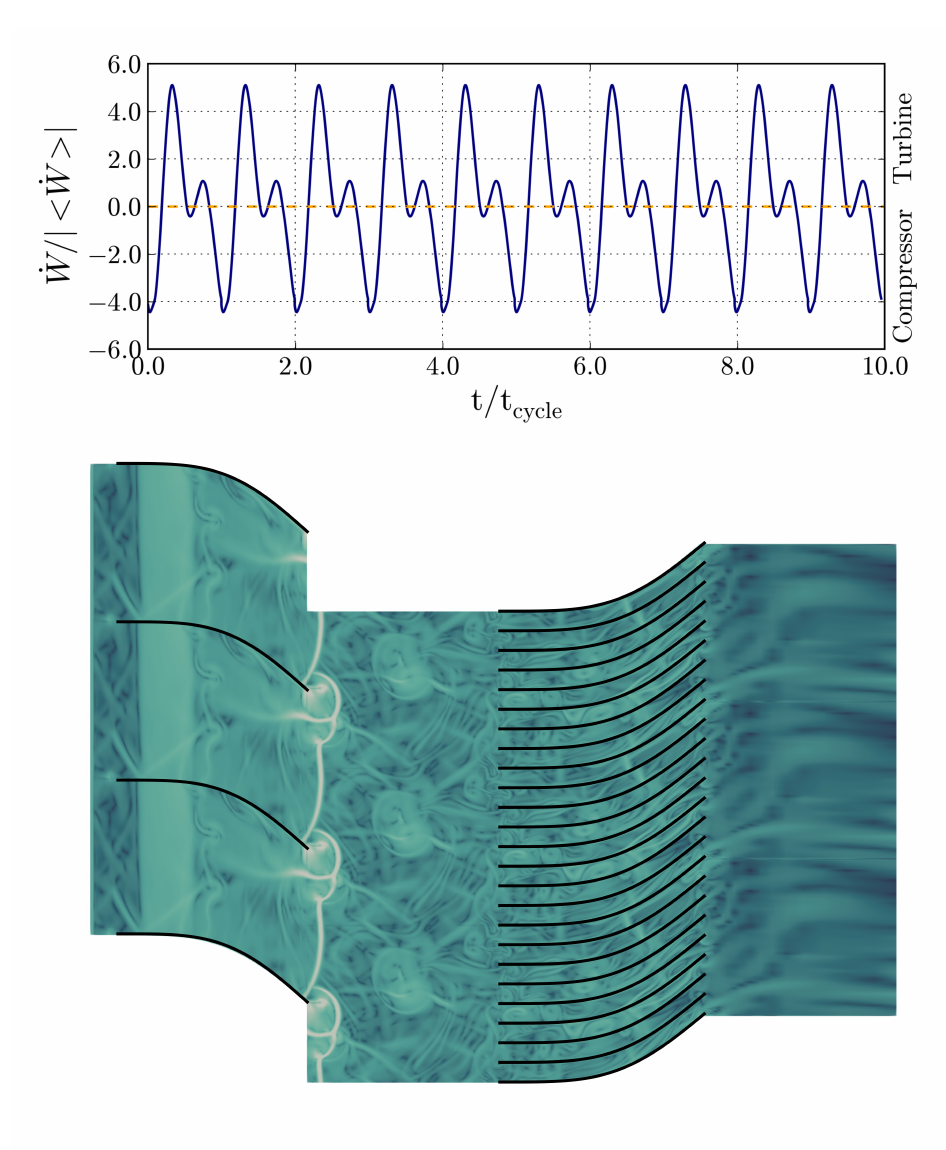
Figure 2. Above: Temporal evolution of ˙ W ( t ) . ˙ W < 0 corresponds to compressor mode. Below: Instantaneous visualization of the density gradient. Simulation n ◦